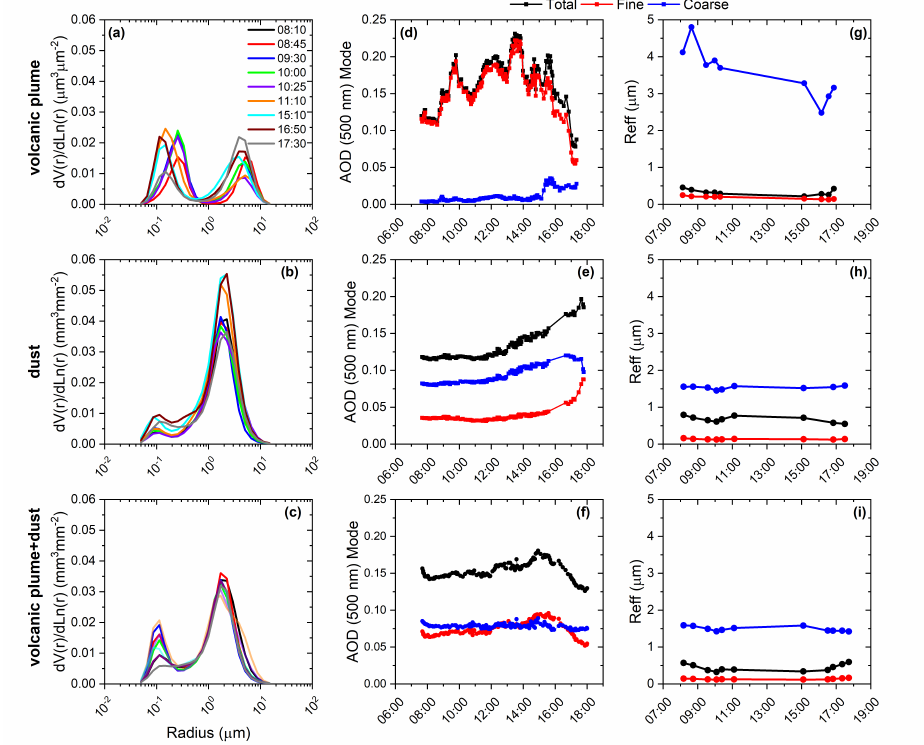
Figure 6. ( a – c ) Volume particle size distribution. The colours indicate the times of the measurements. ( d – f ) Time series of total-, fine-, coarse-mode AODs at 500 nm and ( g – i ) effective radii ( R ef f ) of total, fine, and coarse modes for the three case studies at the IZO: volcanic plume, dust, and volcanic plume +